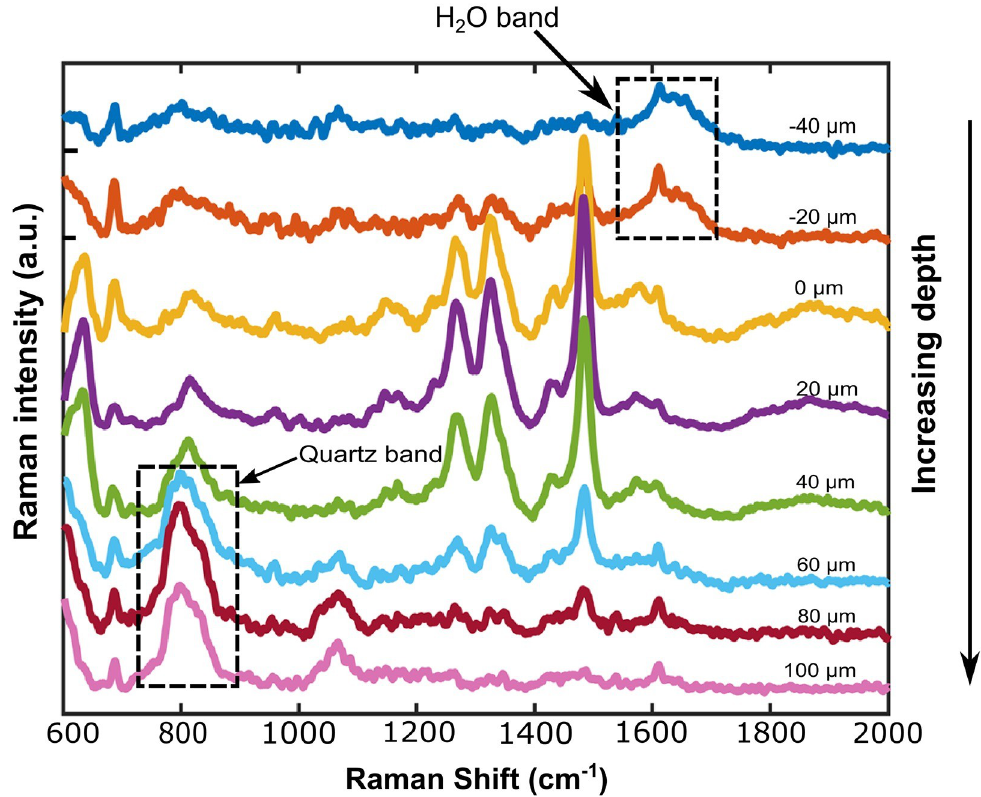
Fig 6. Depth scanning spectra of a representative O . viverrini egg. The egg was scanned from the saline overlayer through the egg and into the supporting quartz material with a 20 μ m increment. Spectra were offset for clarity of